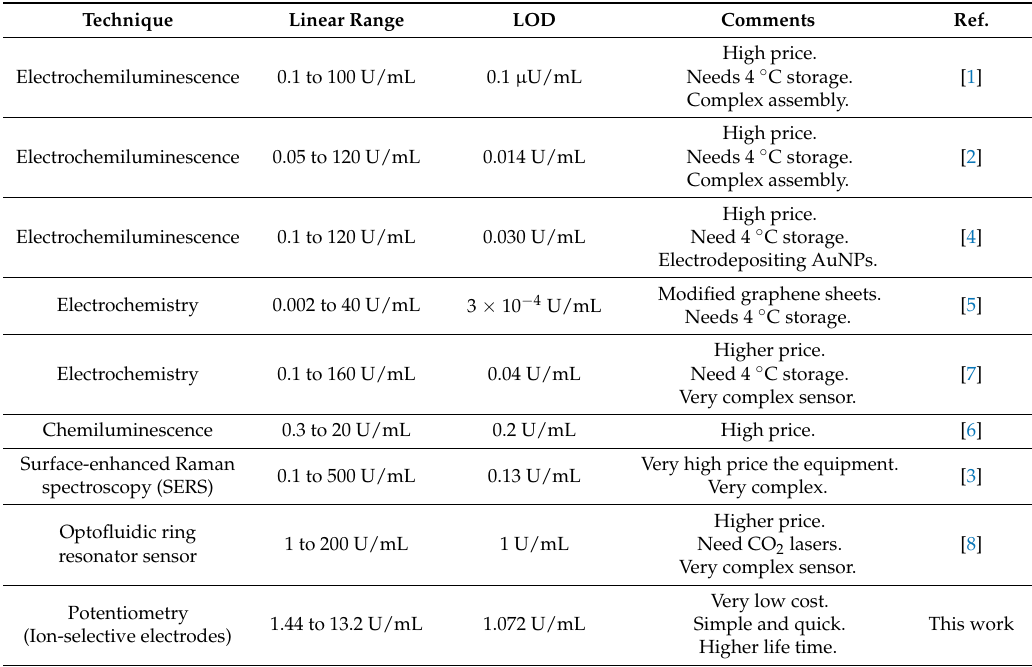
Table 7. Comparison of methods for detection of